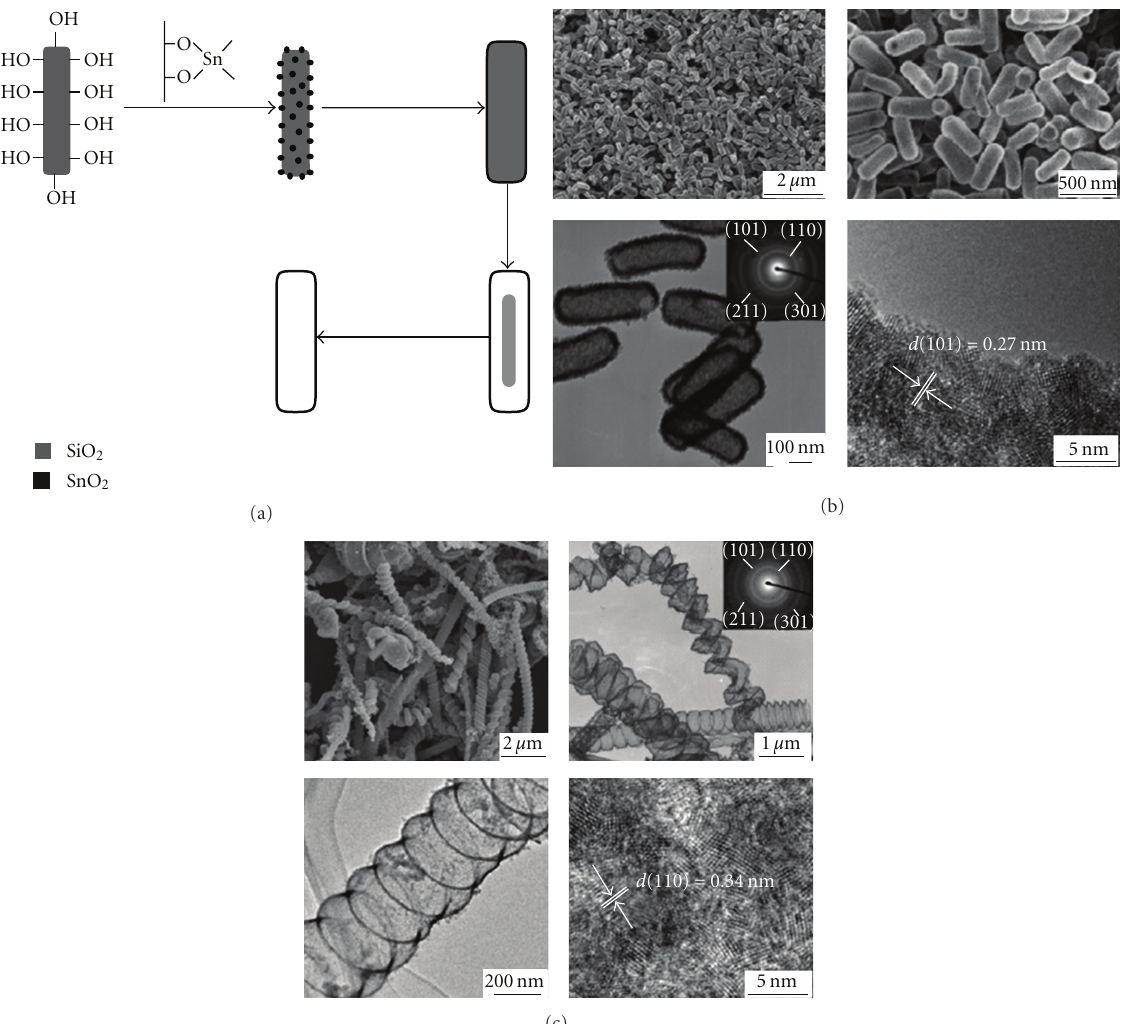
Figure 2: (a) Schematic illustration of a tentative mechanism for the template-directed formation of SnO 2 nanotubes. SEM and TEM images of (b) short and (c) helical SnO 2